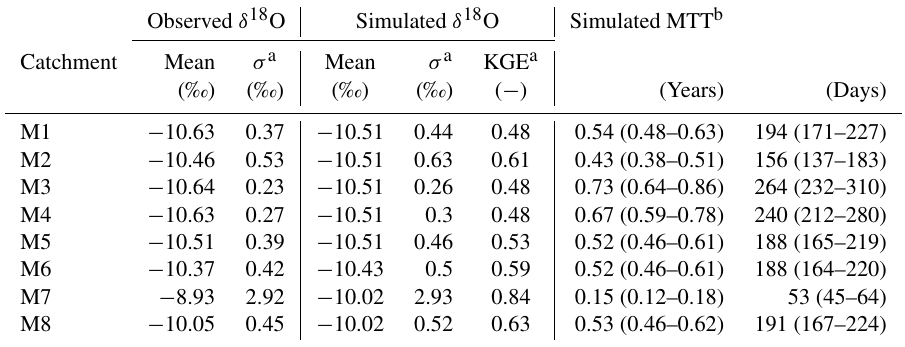
Table 6. Statistical parameters of observed and simulated δ 18 O for all catchments using the exponential model